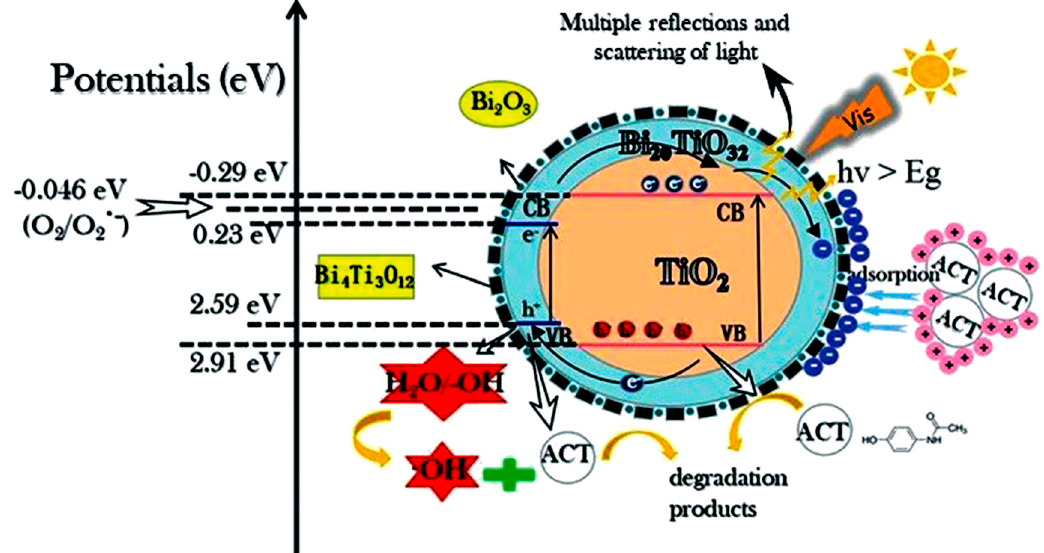
Figure 2. The proposed mechanism of ACT photocatalytic reaction by using Bi − TNR under visible light radiation. Reprinted/adapted with permission from Ref. [63]. Copyright 2018 Royal Society of Chemistry.